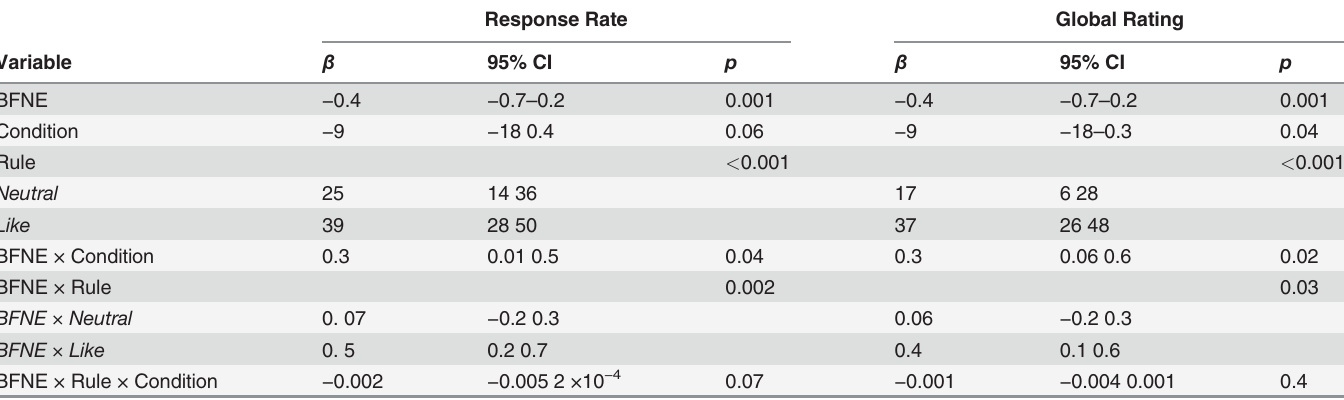
Table 3. Regression coefficients (95% CI) from regression models testing for interactions of rule and self-referential condition with BFNE for the positive response proportion and global ratings in the social learning task.